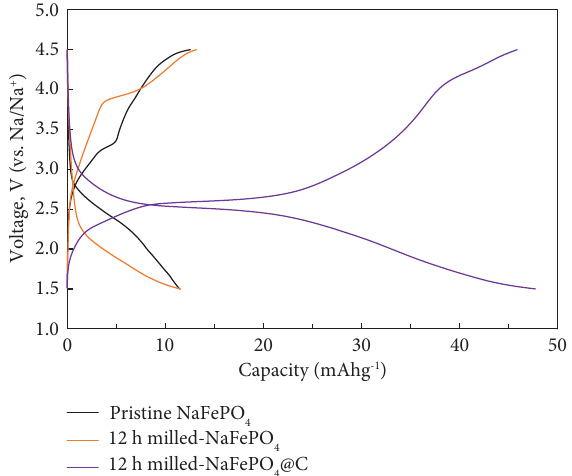
Figure 7: DSC diagram of 12h ground (uncalcined) m-NaFePO (green) compared to that of original NaFePO 4 (red).